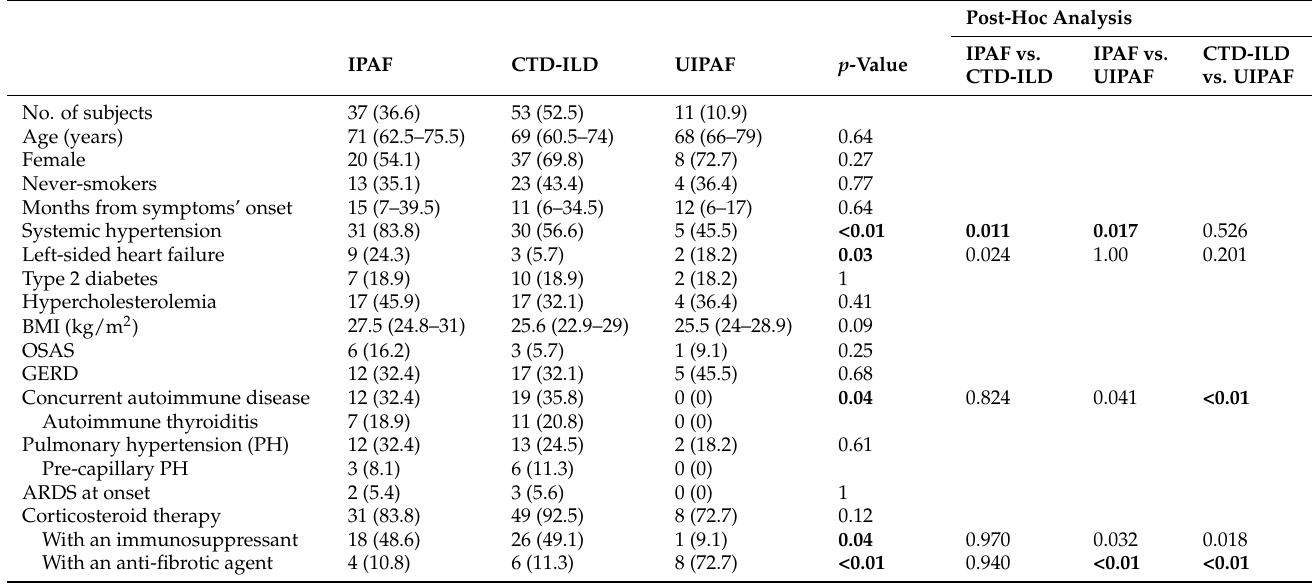
Table 1. Clinical characteristics of IPAF, CTD-ILD, and UIPAF patients at diagnosis.